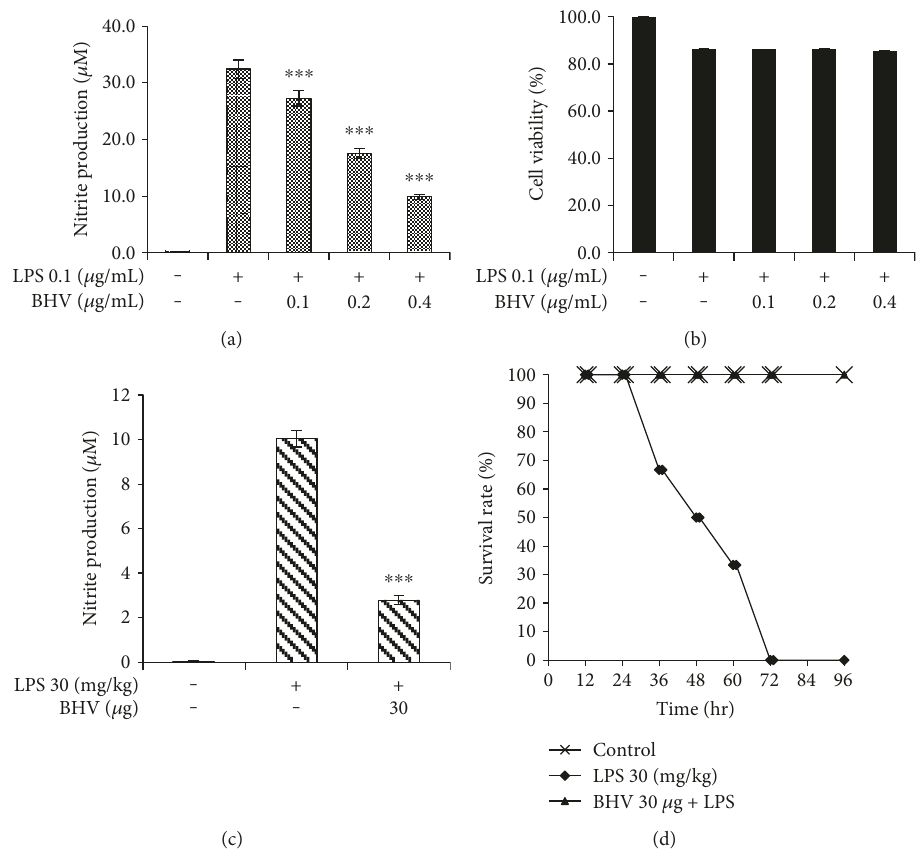
Figure 1: B. hebetor venom suppressed LPS-mediated NO release without any cytotoxicity. RAW 264.7 cells were seeded in 96-well plates for 18hr and then preincubated with BHV (0.1 μ g/mL – 0.4 μ g/mL) for 30min and then stimulated with LPS (0.1 μ g/mL) for 18 hr. The cell supernatant was transferred to a 96-well plate and reacted with equal amounts of Griess reagent, and then NO production was measured at 540nm (a). E ff ects of BHV on cell viability were measured by MTT assay and absorbance was measured at 560 nm (b). NO production was also observed in mice chronically treated with LPS (c). For survival rate, mice were given LPS injection with a lethal dose of 30 μ g/kg and monitored for 96 hours (d). Values in bar graph are mean ± SEM of at least 3 independent experiments. ∗∗∗ p < 0 001 compared to LPS